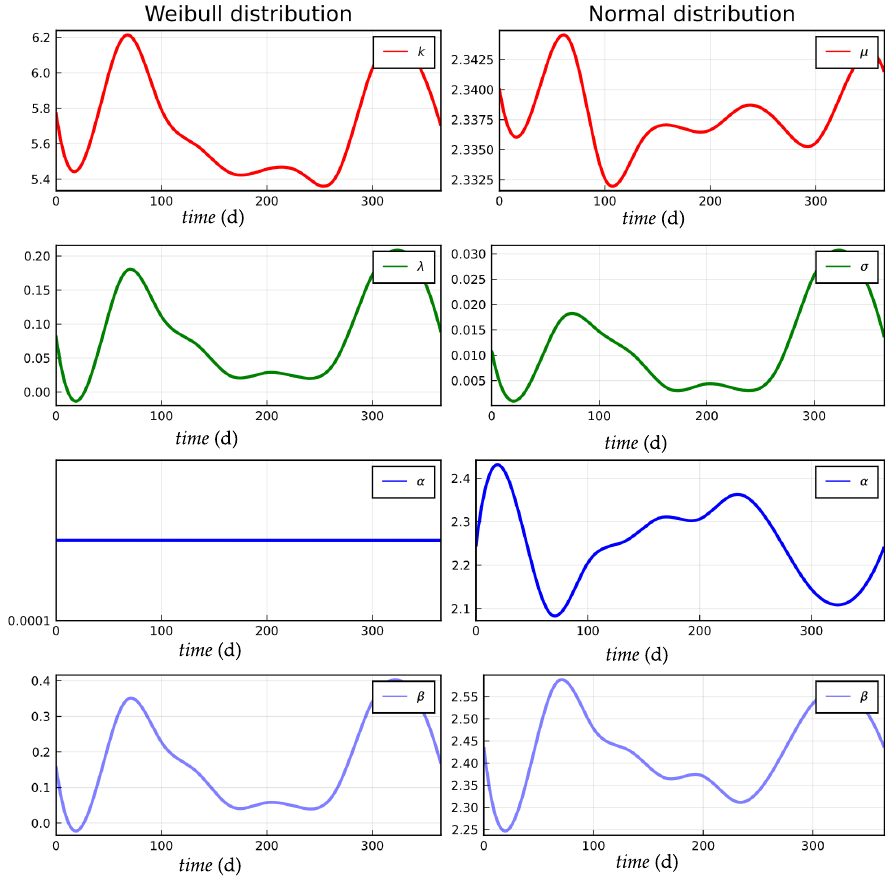
Figure 14. Yearly parameters spaces for confined Weibull and normal distributions.